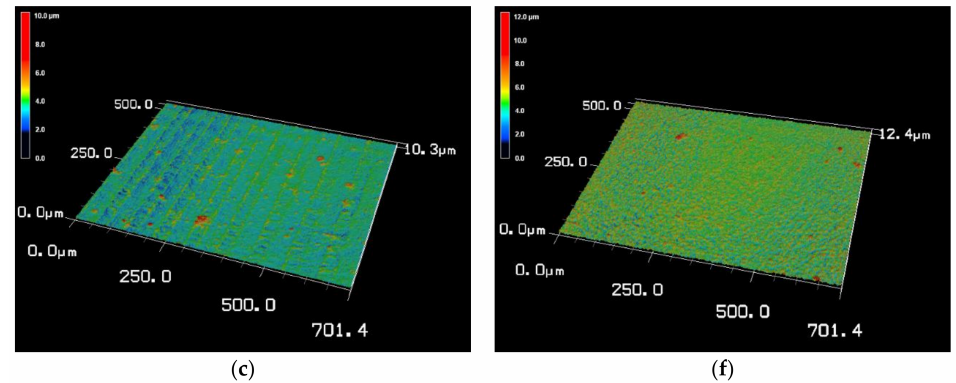
Figure 1. 3D surface morphologies of the Ti-V-O coatings after laser surface texturing oxidation (LSTO) treatment at laser frequencies of ( a ) 100 kHz; ( b ) 300 kHz; and ( c ) 500 kHz; and Ti-V-O coatings after high-temperature annealing (HTA) treatment at ( d ) 500 ◦ C; ( e ) 600 ◦ C; and ( f ) 700 ◦